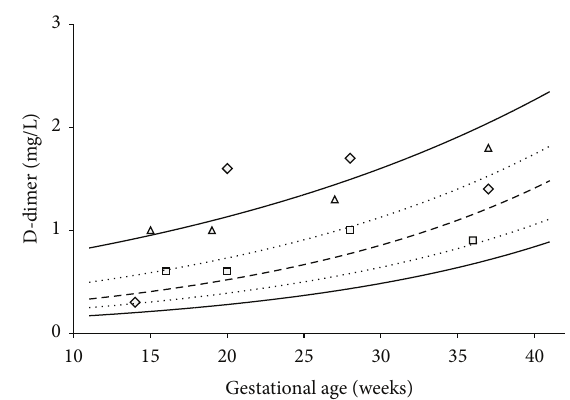
Figure 4: D-dimer concentrations as 5th, 25th, 50th, 75th, and 95th percentiles for each gestational week. D-dimer fluctuations for three randomly selected women are illustrated (square, triangle, and diamond). In spite of all having normal pregnancies, several women had stable high or low D-dimer values, while other had fluctuating D-dimer values throughout the pregnancy. Similar patterns are observed during